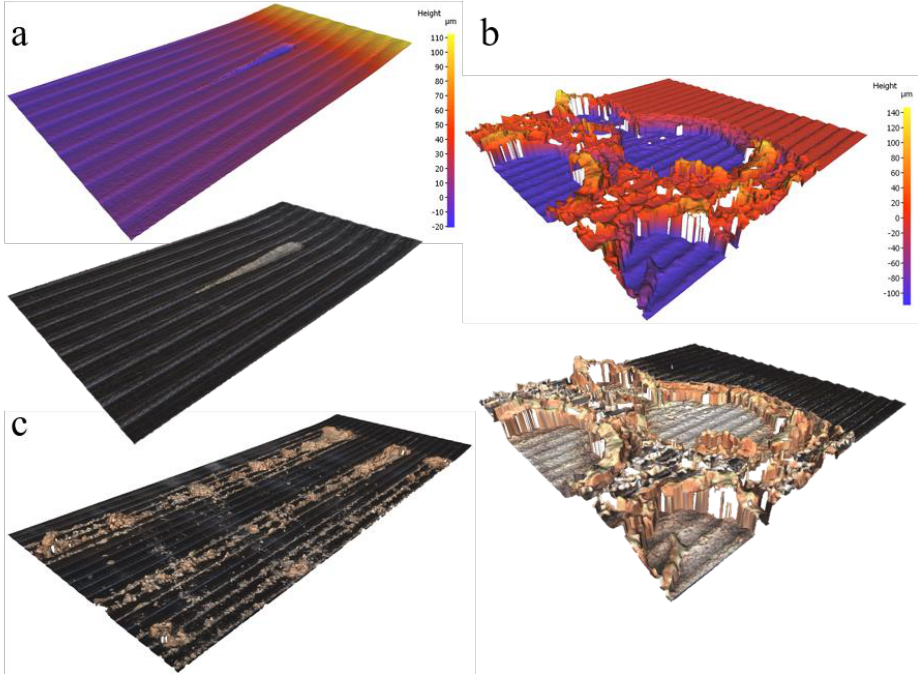
Figure 15. Representative 3D reconstructions of localized crevice corrosion on samples G2 ( a , c ) and G1 ( b ). Image ( a ) shows the initiation of crevice corrosion on sample G2. Image ( b ) shows the corrosion pits at the initiation point of corrosion at the end of the test of sample G1. Image ( c ) corresponds to the whole area of G2 samples after the completion of the PDP tests.